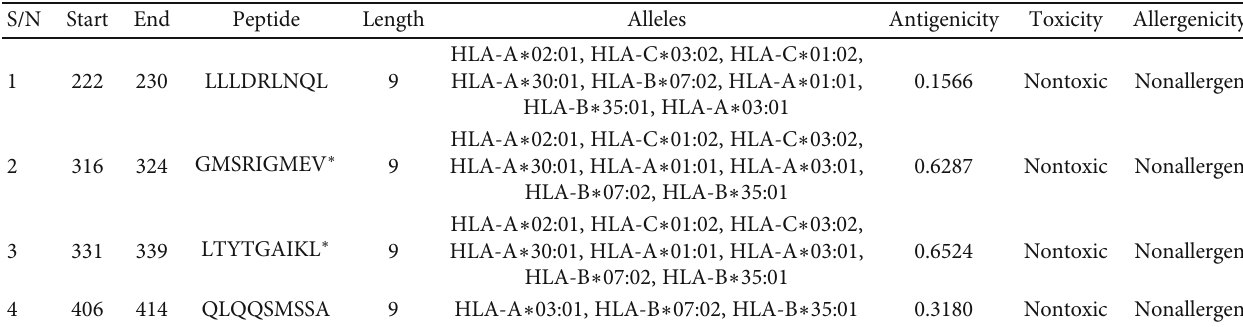
Table 3: MHC-I epitopes of SARS-CoV-2